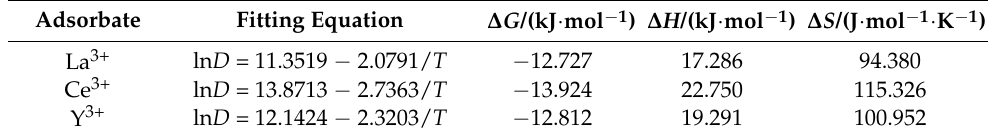
Table 8. Results of thermodynamic parameters.